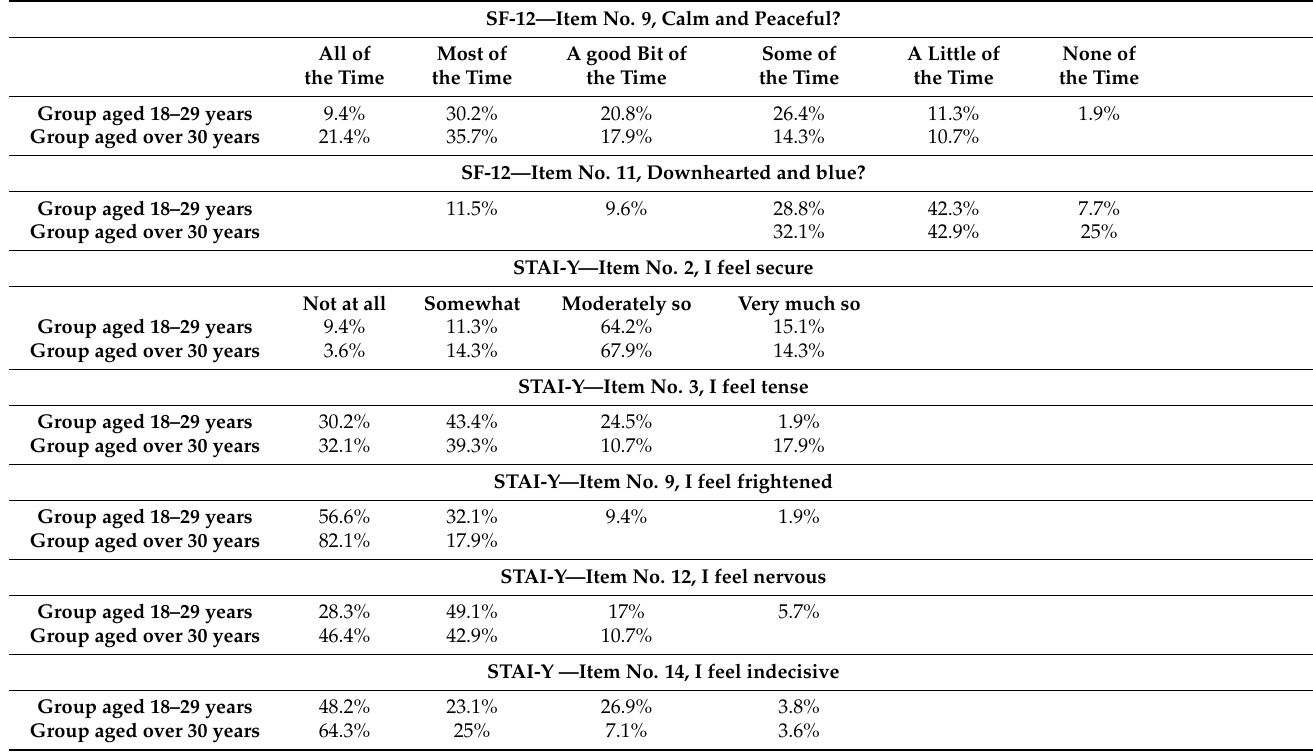
Table 1. Percentage of the frequencies of responses to specific items of the